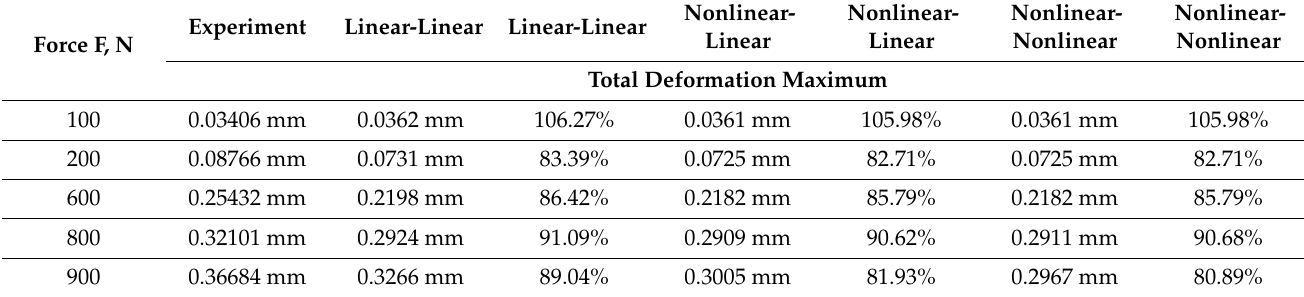
Table 4. Comparison of the elongations of the riveted joint obtained numerically and experimentally, for different force values, with the percentage error to the experimental